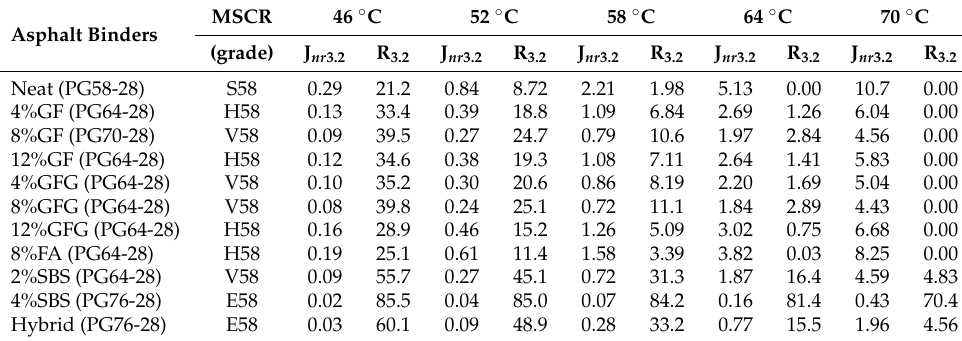
Table 4. Temperature effect on the J nr 3.2 and R 3.2 of asphalt